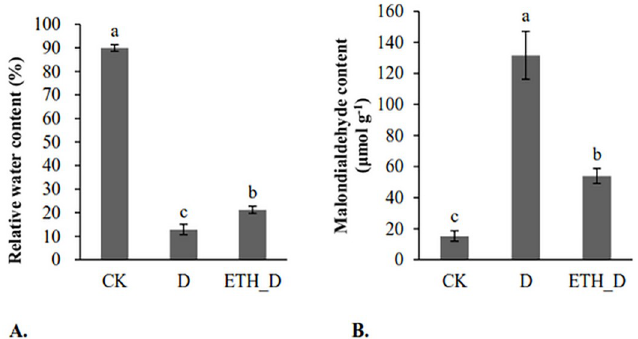
Fig 2. A. Relative water content of each samples B. Malondialdehyde content of each treatment. CK means well- watered control plants without ethephon application. Drought means drought-stressed plants without ethephon application. ETH_D means drought-stressed plants with ethephon pre-treatment.